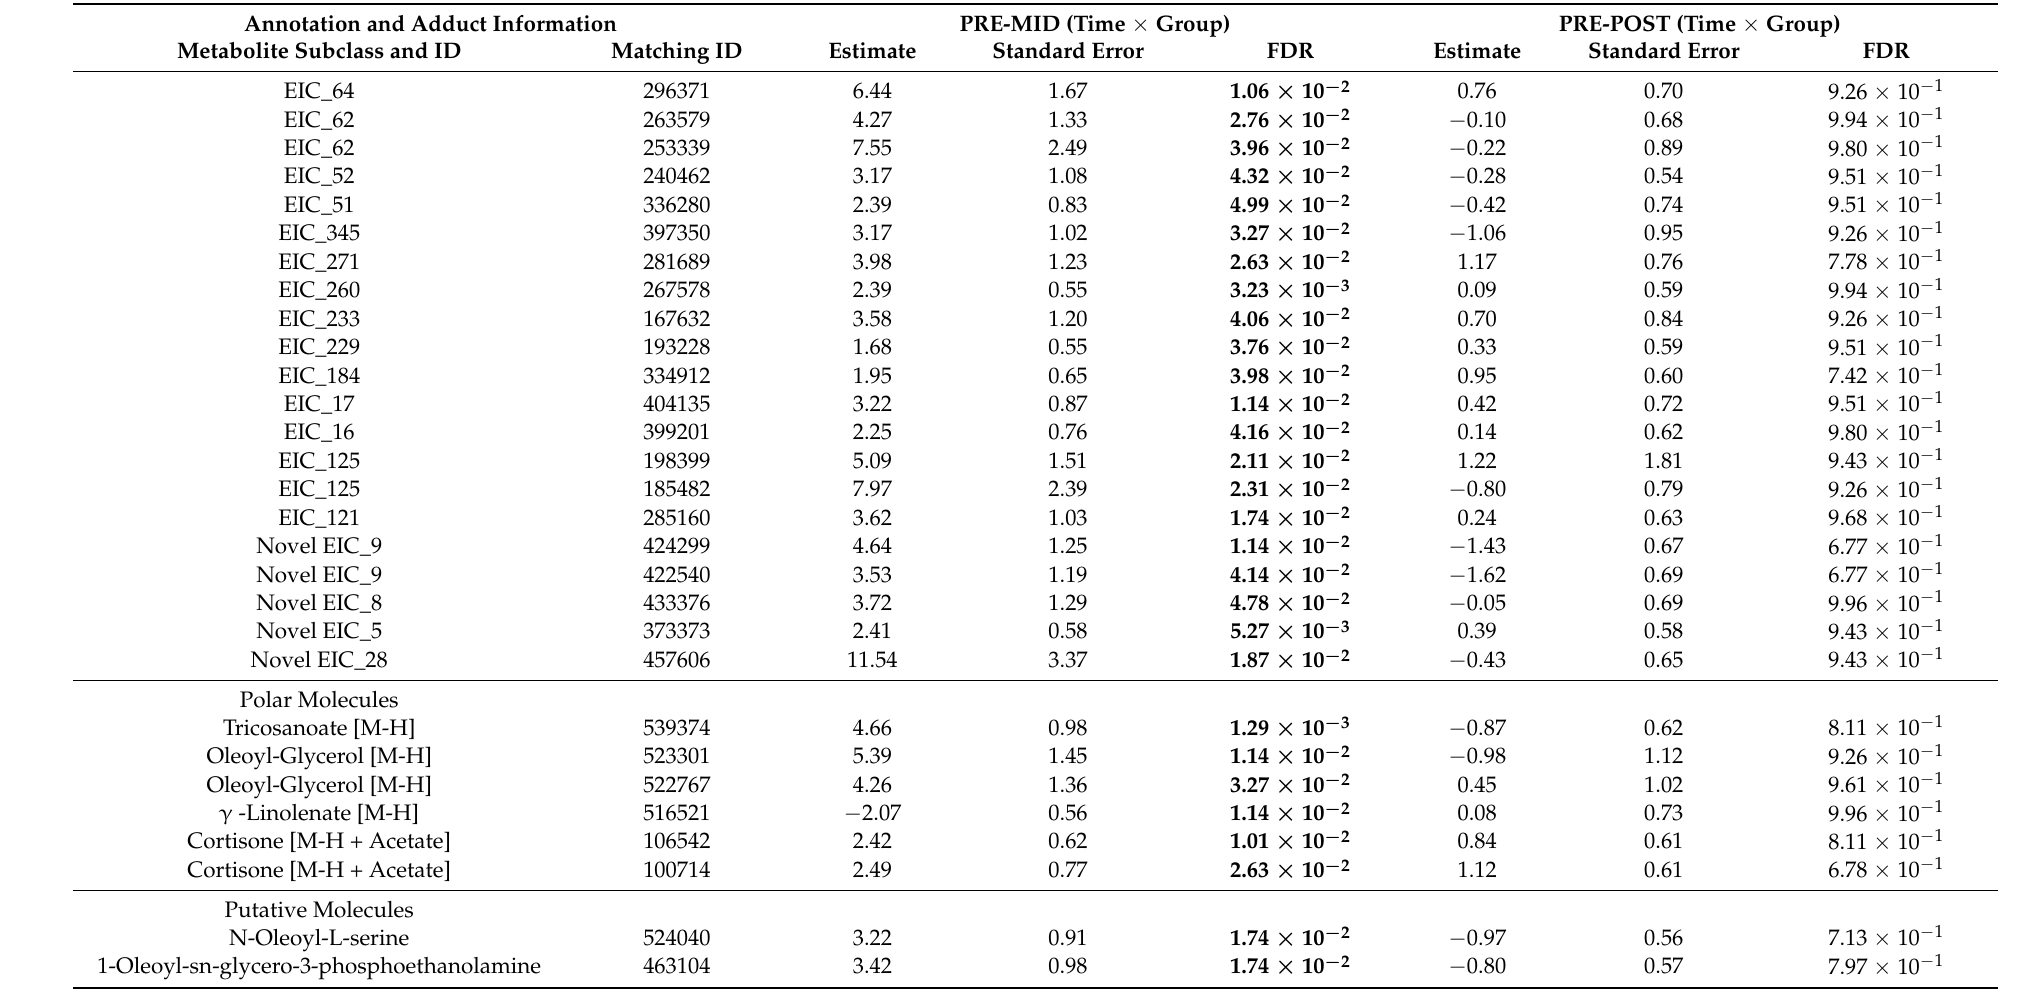
FFA = Free Fatty Acid. EIC = Eicosanoid. FDR = False Discovery Rate. FDR < 0.05 (i.e., <5 × 10 − 2 ) are bolded in the table. Results are derived from 4 standard deviation from mean quality-controlled data. Table is ordered based on metabolite feature subclasses. Statistical significance was calculated using Generalized estimation equations (~Time × Group +